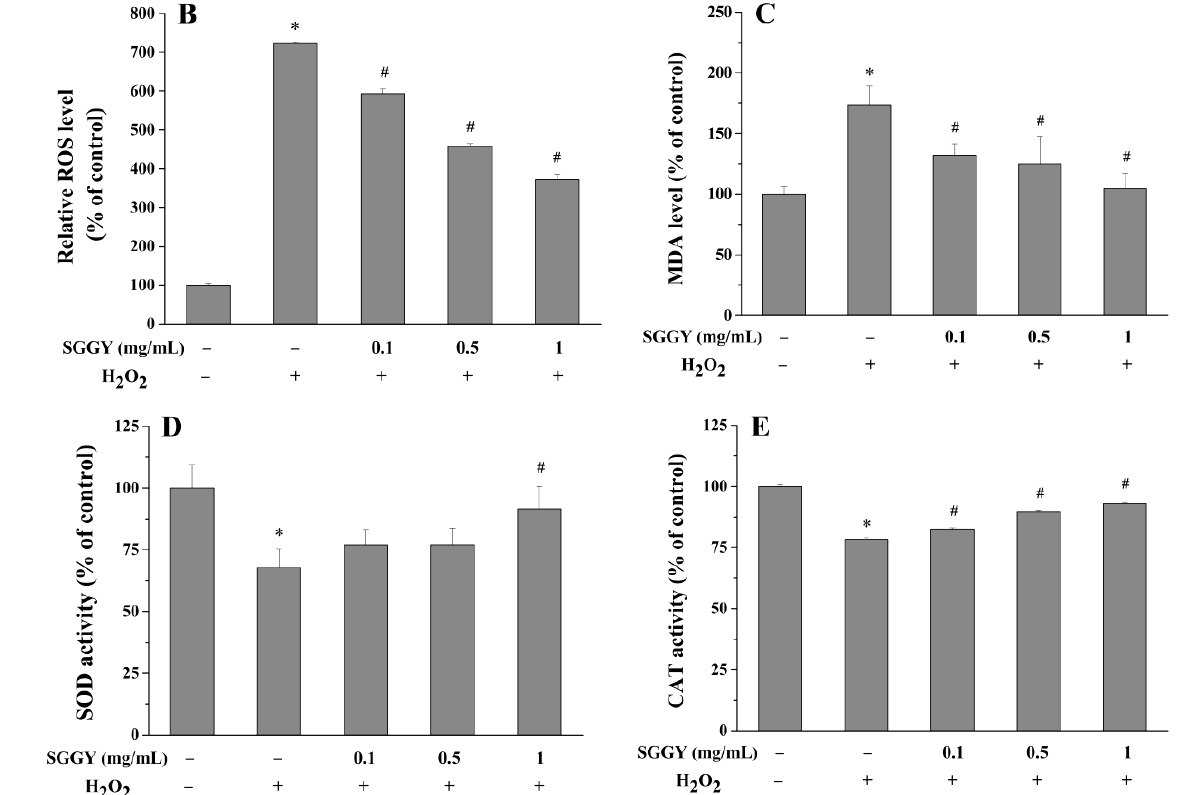
Figure 3. SGGY suppressed H 2 O 2 -triggered redox imbalances in SH-SY5Y cells. Cells were pre- incubated with indicated concentrations of SGGY (0.1, 0.5, and 1 mg/mL) for 12 h and subsequently exposed to 900 µ M H 2 O 2 for 2 h. After staining with DCFH-DA, the oxidative status of the cells was visualized by a fluorescence microscope. The green colors represented the DCFH-DA fluorescence intensity in SH-SY5Y cells. The brighter the green colors, the stronger the fluorescence intensity. ( A ); the fluorescence intensity was detected by a fluorescence microplate reader. ( B ) Relative level of intracellular ROS. MDA ( C ), SOD ( D ) and CAT ( E ) levels in SH-SY5Y cells were detected. * p < 0.05 vs. control group, and # p < 0.05 vs. H 2 O 2